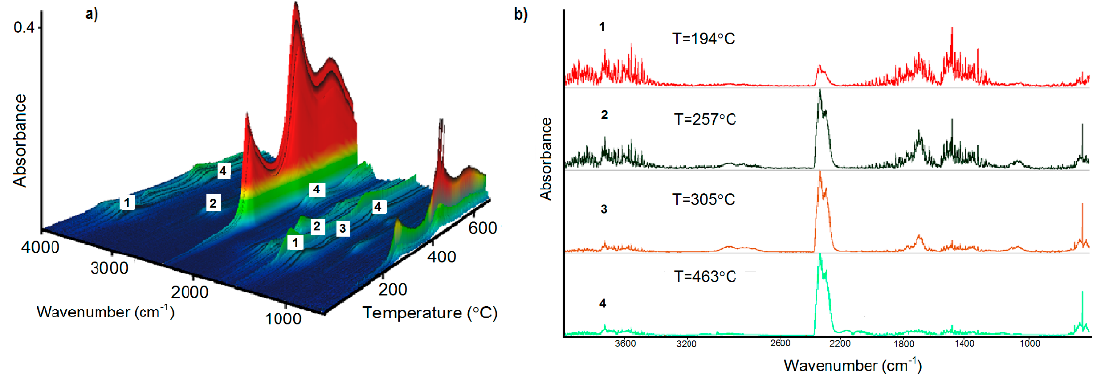
Figure 8. ( a ) 3D representation of FTIR spectra of evolved gases during the decomposition of 2 ; and ( b ) FTIR spectra of gaseous products recorded at different temperatures.